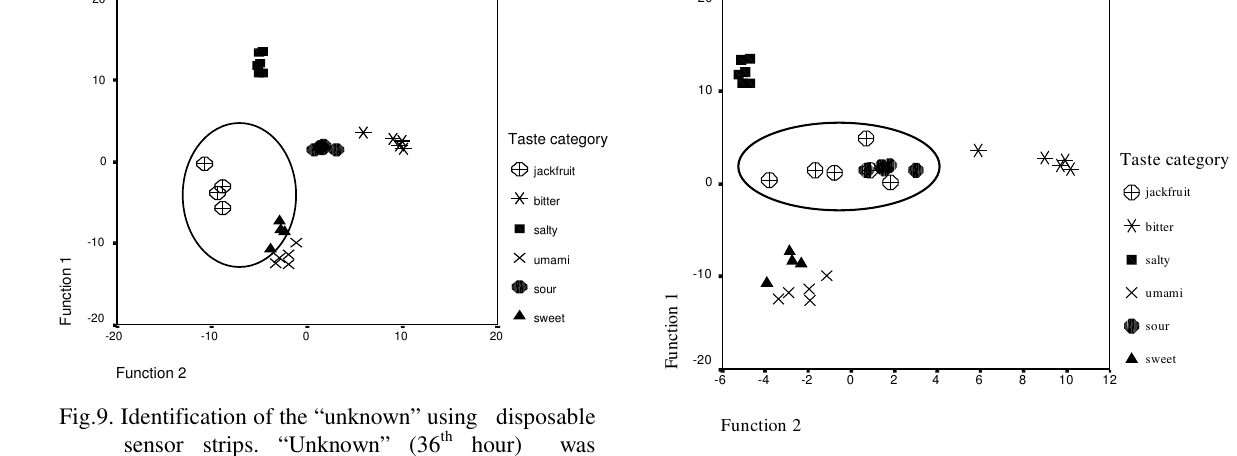
Fig.10. The construction of the classification model by CDA enables unknown taste of jackfruit (from the time interval of 156 th hour onwards) to be identified (with reference to Table